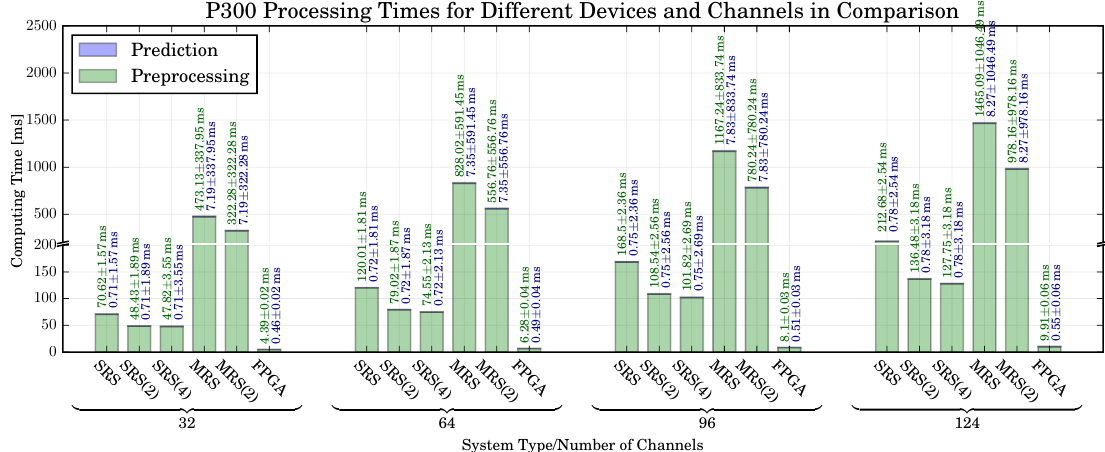
Figure 11. Computing times of different computing setups for 32–124 channels for the detection of the